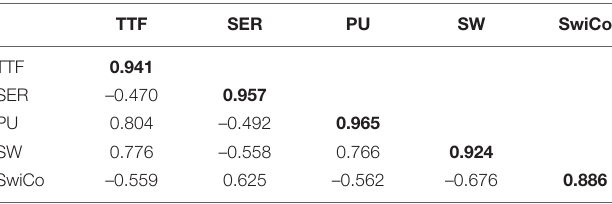
TABLE 2 | Analysis of discriminant validity (Fornell–Larcker Criterion).